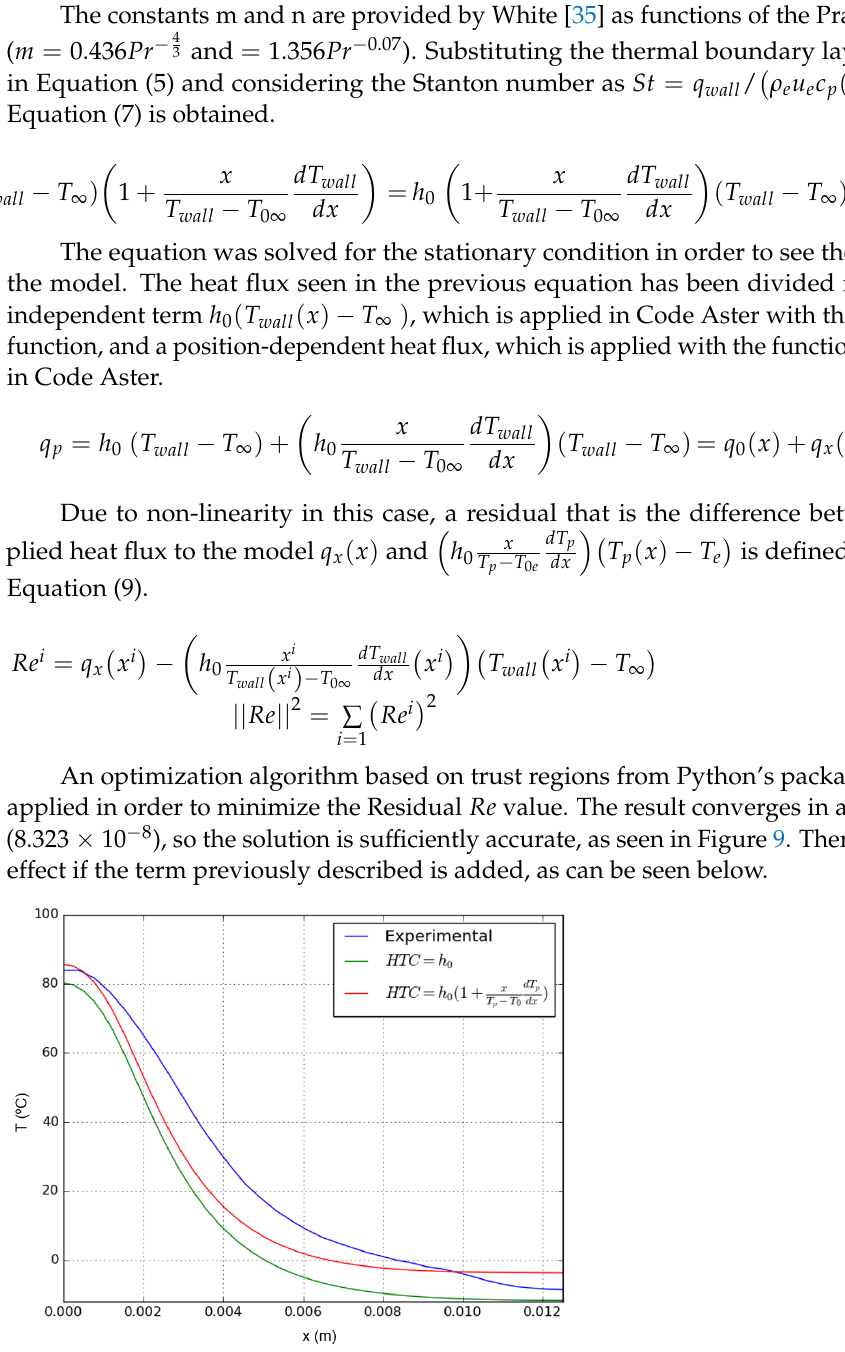
Figure 9. Comparison between the experimental Temperature, the FEM model without correction Temperature, and FEM with the corrected Heat Transfer Coefficient Temperature. Temperature, and FEM with the corrected Heat Transfer Coefficient